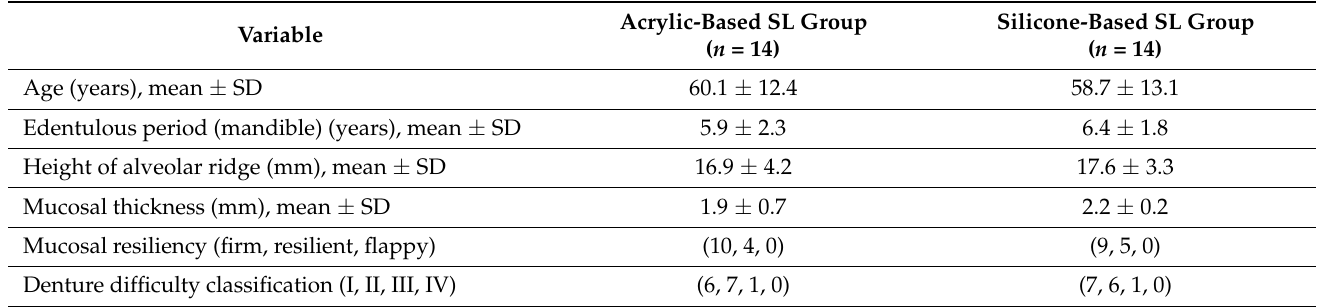
Table 1. Baseline characteristics of the study participants.